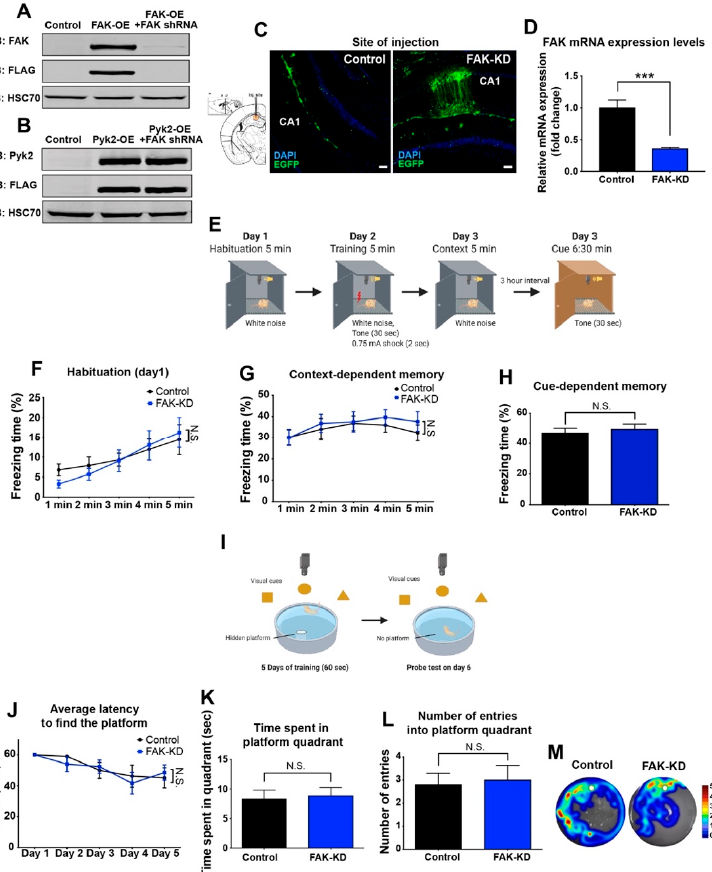
Figure 1. Hippocampal depletion of FAK in 3xTg-AD mice does not significantly affect their learn- ing and memory capabilities. ( A ) HEK293T cells were transfected with FLAG-tagged control viral vector, vector expressing FAK (FAK-OE) or vector expressing FAK and a knockdown vector (FAK- KD). Expression and knockdown were verified by immunoblot analysis. ( B ) HEK293T cells were transfected with FLAG-tagged control viral vector, vector expressing Pyk2 (Pyk2-OE) or vector expressing a knockdown vector for FAK (FAK-KD). The specificity of FAK-KD vector to FAK only and not to Pyk2 was verified by immunoblot analysis. ( C ) Left, diagram of the coordinates for site injection of CA1 region from the Allen mouse brain atlas. Right, representative confocal im- ages of control and FAK-KD hippocampi. Green: Enhanced green fluorescent protein (EGFP); blue: 4 w, 6-diamidino-2-phenylindole (DAPI) DNA stain. Scale bar, 100 µ m. ( D ) FAK mRNA expres- sion levels in hippocampi of 3xTg-AD mice injected with control or FAK shRNA lentiviral vector. N = 5 mice per group, *** p = 0.0009 by an unpaired Student’s t -test. ( E ) Schematic diagram of the fear conditioning paradigm. ( F ) Freezing response during habituation on the first day of fear conditioning paradigm. p = N.S. by two-way ANOVA with the Bonferroni post hoc test. ( G ) Freezing response in context-dependent memory test. p = N.S. by two-way ANOVA with the Bonferroni post hoc test. ( H ) Freezing response in cue-dependent memory test. p = N.S. by an unpaired Student’s t -test. ( I ) Schematic diagram of the Morris water maze paradigm. ( J ) Average latency to find the platform during 5 days of acquisition phase. p = N.S. by two-way ANOVA with the Bonferroni post hoc test. ( K ) Time spent in the platform quadrant during the probe test day. p = N.S. by an unpaired Student’s t -test. ( L ) Analysis of the number of entries into the platform quadrant during the probe test day. p = N.S. by an unpaired Student’s t -test. ( M ) Representative heatmaps of control and FAK-KD mice during the probe test day. Location of the platform is indicated by the white